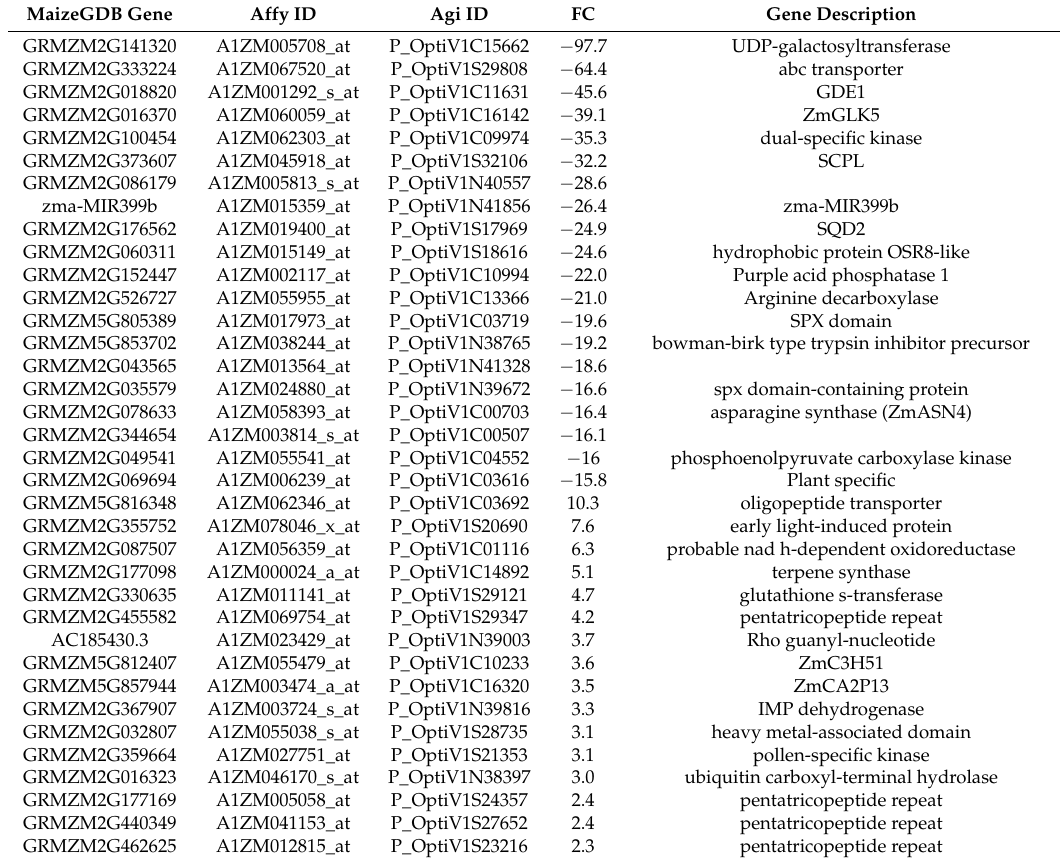
Table 4. Top common down-regulated and up-regulated genes under low N versus sufficient N treatments (Lines 1–4, A188 and